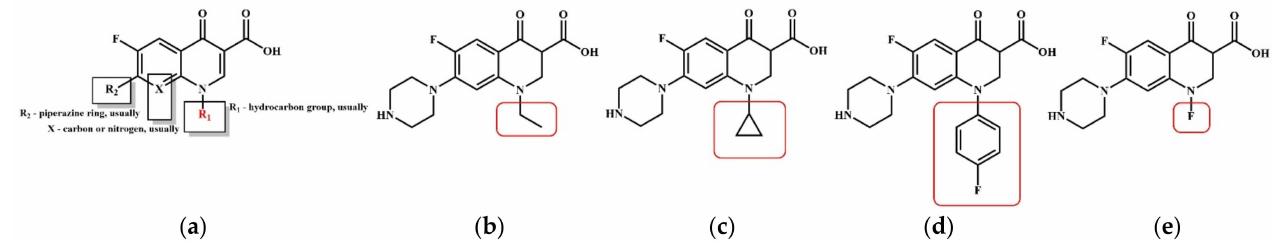
Figure 7. Molecular structure of FQs and derivative D-5: ( a ) Maternal structure of FQs; ( b ) Norfloxacin (NOR); ( c ) Ciprofloxacin (CIP); ( d ) Sarafloxacin (SAR); ( e ) Derivative